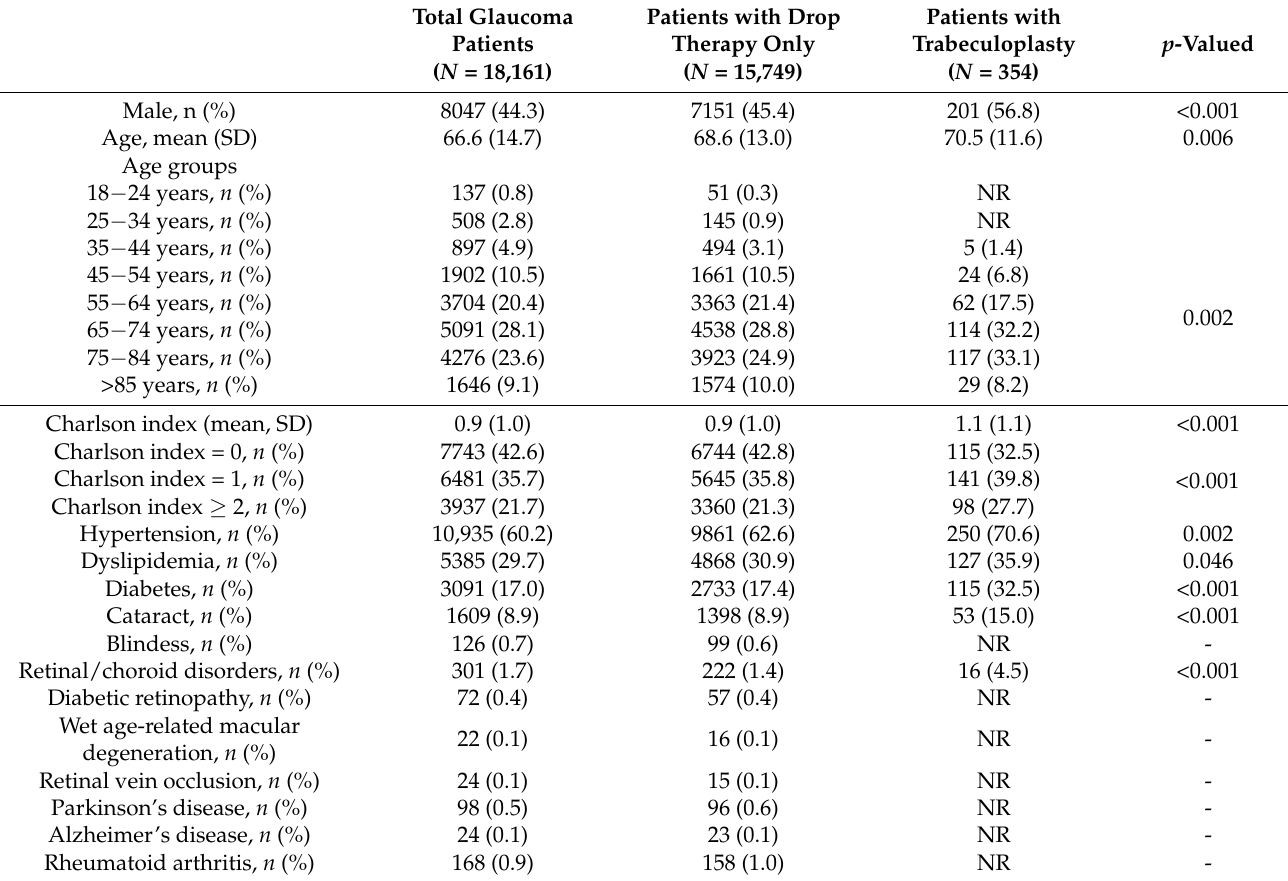
Table 1. Characteristics of glaucoma patients.